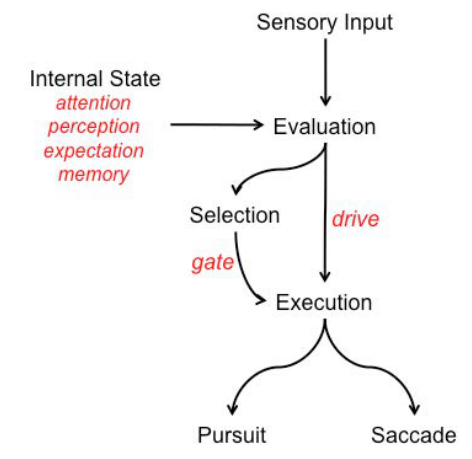
Figure 2. A hypothetical model of the functional organiza- tion of voluntary eye movements adapted from Krauzlis